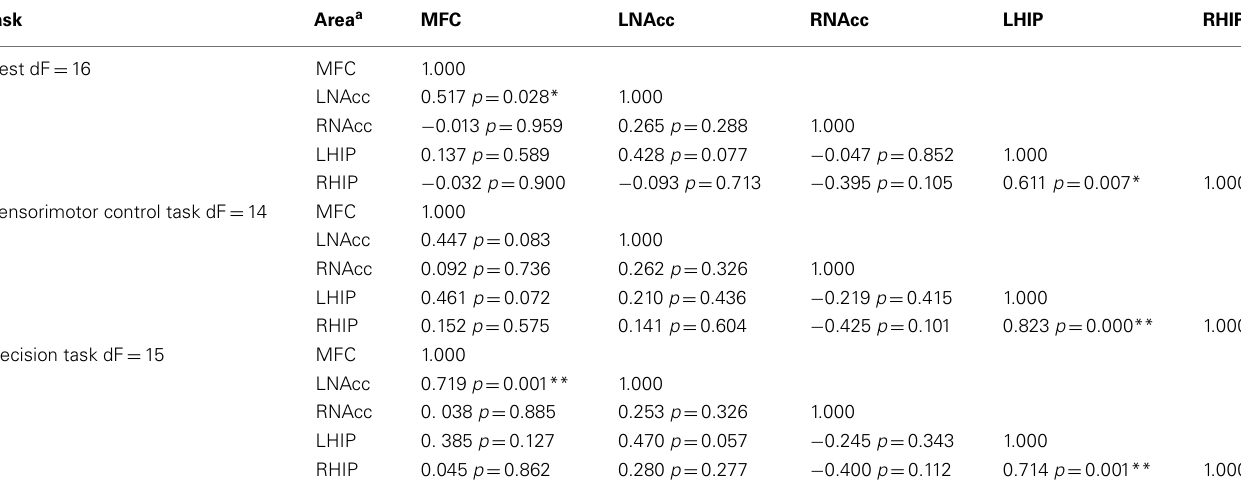
Table 8 | Functional connectivity between regions of interest during three task conditions at week